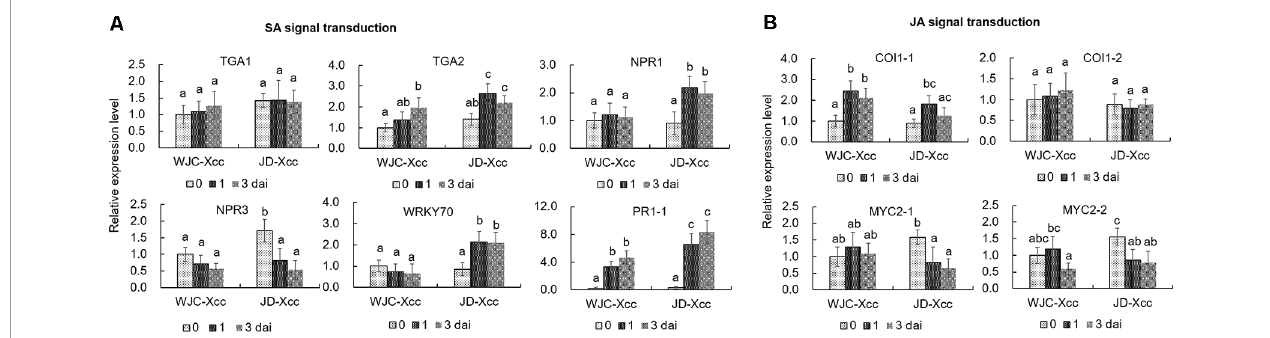
FIGURE 4 | Expression levels of genes involved in SA and JA signal transduction. (A) Expression levels of genes involved in SA signal transduction. (B) Transcriptional levels of genes involved in JA signal transduction. Leaves from Wanjincheng orange (S) and Jindan (R) were inoculated with the canker pathogen Xcc by injection, and samples treated with water were used as blank controls. Expression levels of genes were assessed by qRT-PCR before and after inoculation. Error bars represent the SDs of three biological replicates. Different letters above bars represent signi fi cant differences from the 0 dai of WJC-Xcc based on Duncan ’ s multiple range test ( P < 0.05). WJC, Wanjincheng orange; JD, Jindan; Xcc, Xanthomonas citri ssp. citri ; dai, days after inoculation; TGA, basic region/leucine zipper TGA transcription factors; NPR, non-expressor of PR proteins; WRKY, WRKY family of transcription factors; PR, pathogenesis-related proteins; COI1, coronatine insensitive 1; MYC2, basic helix – loop – helix MYC2 transcription